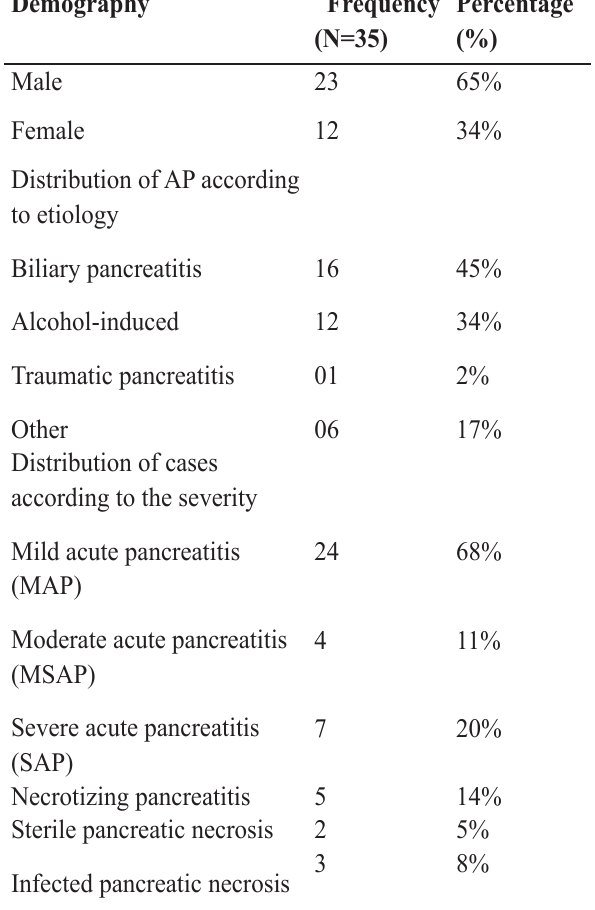
Table 1: Distribution of patients according to demography, etiology, and